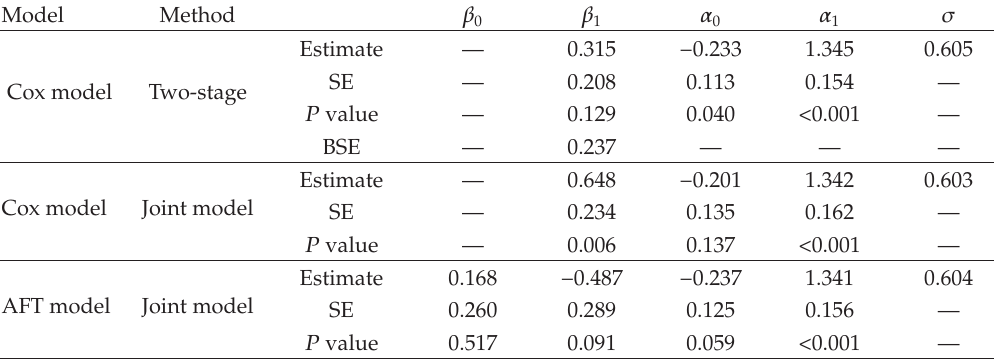
Table 1: Analyses of the AIDS data under di ff erent